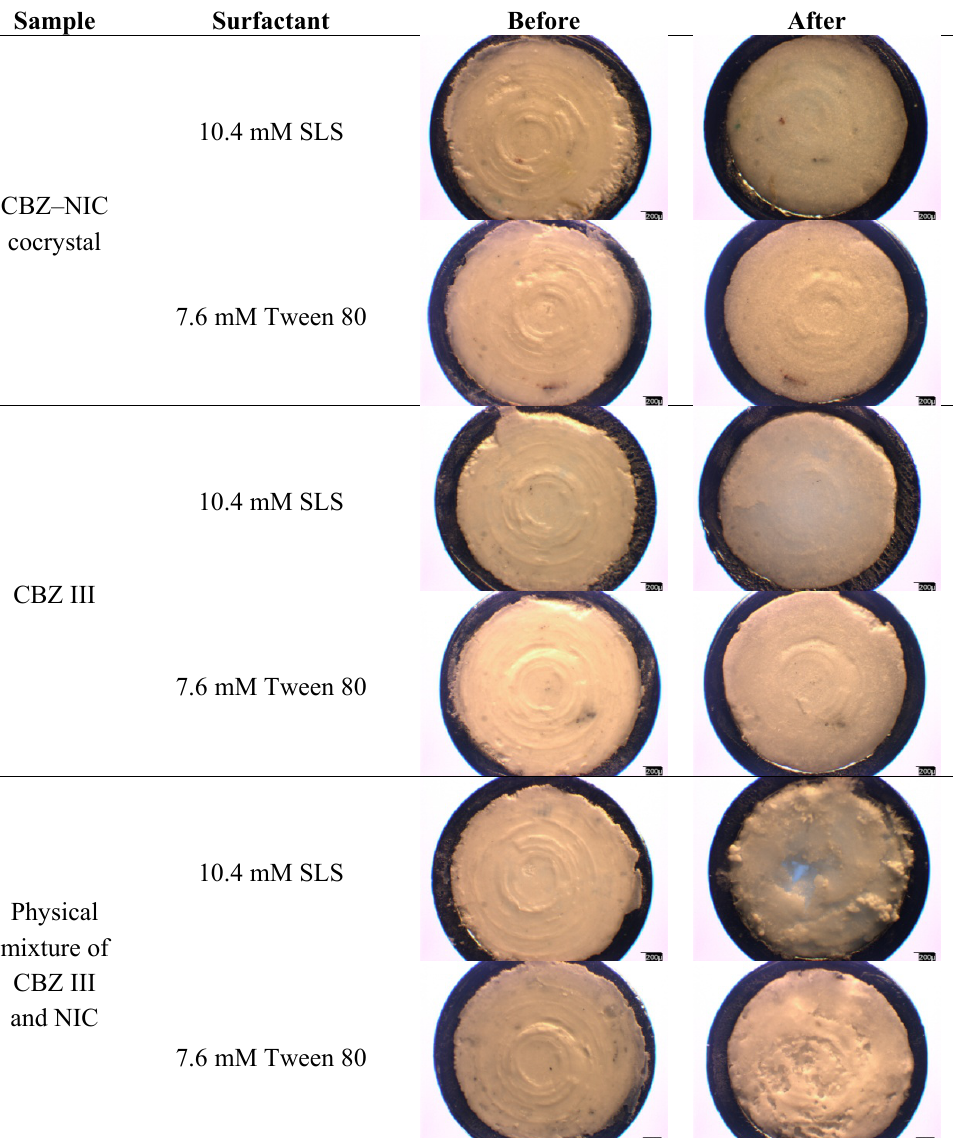
Table 3. Light microscopy photographs of the sample compacts before and